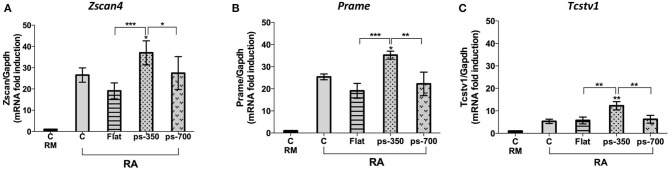
Zscan4 metastate enrichment requires canonical RA induction and specific micropattern plate of growth. The ESZscan_Em cells were cultured for 72 h on plates control CTR (RM and RA), Flat, ps-350, and ps-700 surfaces treated with RA. mRNA expression levels of Zscan4-Metastate genes: Zscan4 (A), Prame (B), Tcstv1 (C) were assessed by qPCR and normalized to RM condition. Error bars represent SD of triplicate samples from three independent biological replicates. Asterisks over the ps-350 column indicate significant difference with respect to the CTR-RA condition. Asterisks over the square brackets indicate significant differences between groups. Levels of significance are: ns > 0.05; *p < 0.05; **p < 0.01; ***p < 0.001.